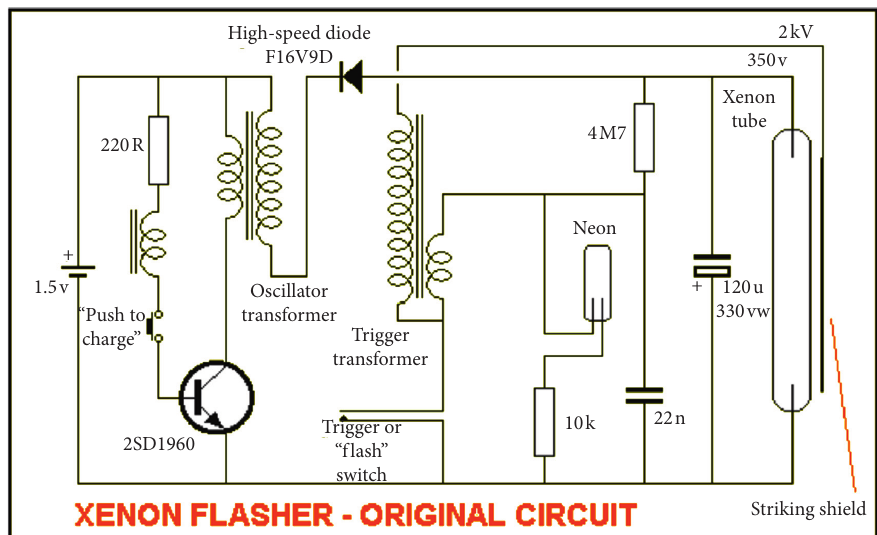
Figure 10: Example of xenon flash circuit (Polytec).